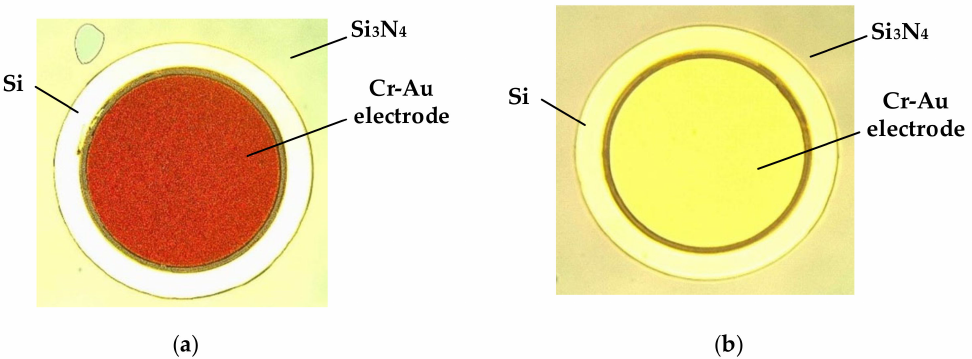
Figure 16. Magnetron sputtering results of a wafer after ( a ) reactive ion etching (RIE) and ( b ) bu ff ered oxide etch (BOE).